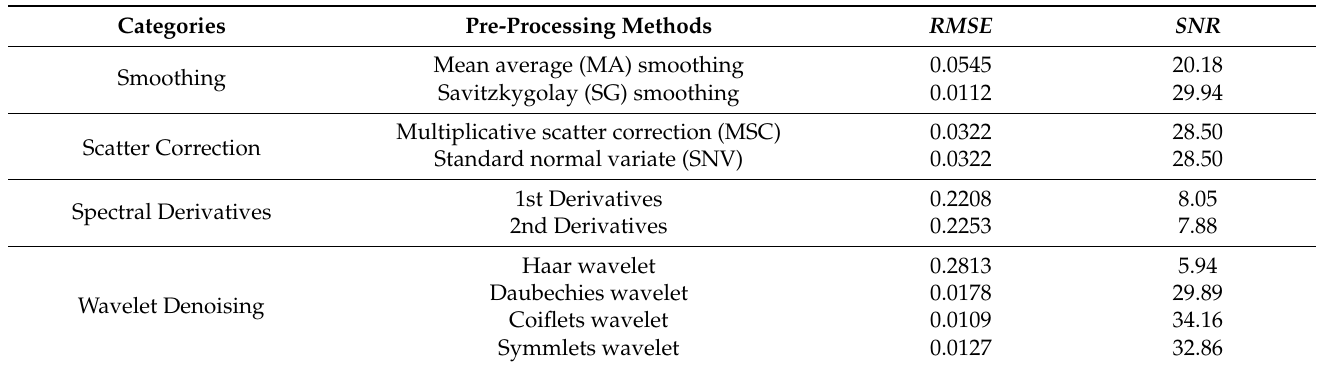
Table 2. Comparison of preprocessing method denoising